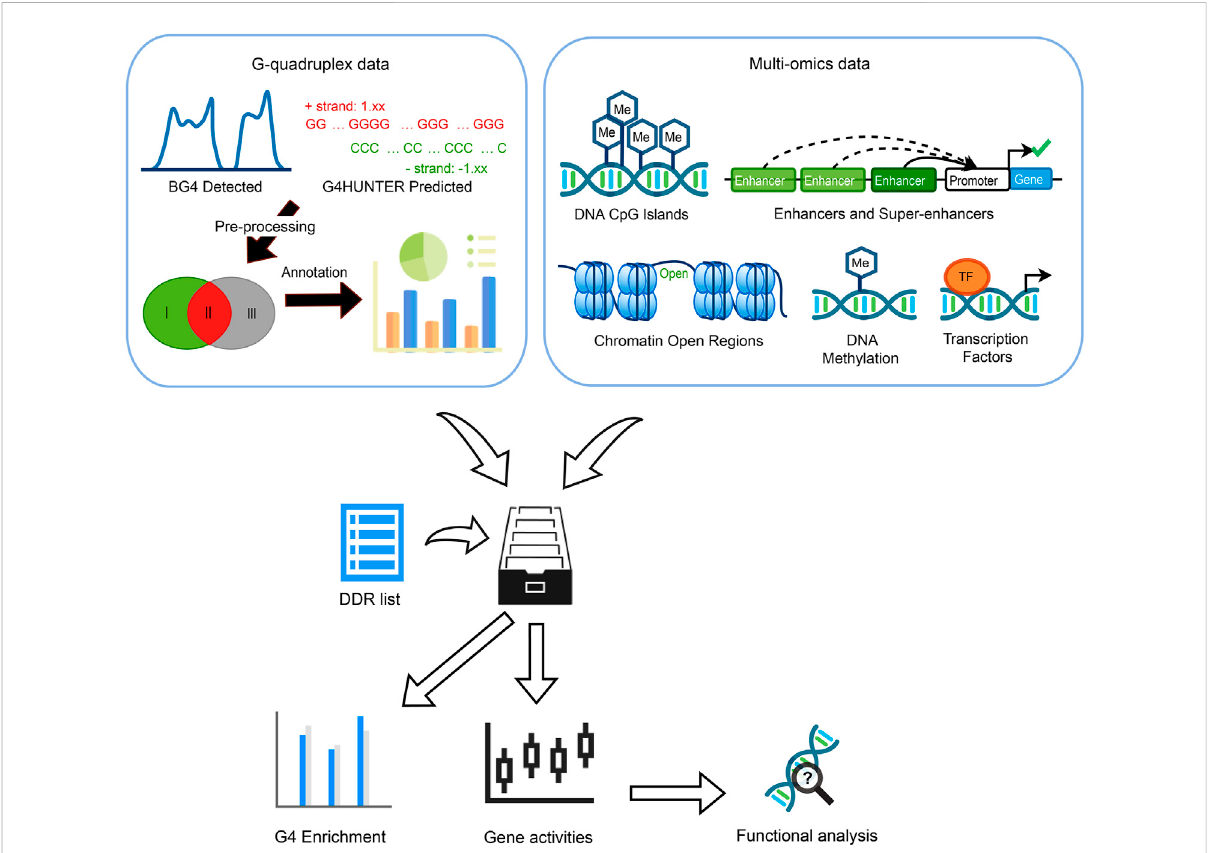
FIGURE 1 Overview of the whole study. Three G4 groups were de fi ned by evidence collected from G4 ChIP-seq and G4Hunter prediction. Multi-omics data including CpG islands, enhancers, super-enhancers (SEs), chromatin accessible/inaccessible regions, DNA methylation as well as transcription factors (TFs) binding sites were incorporated to discover the G4 enrichment, associations between gene expression, G4 formation, and epigenetic